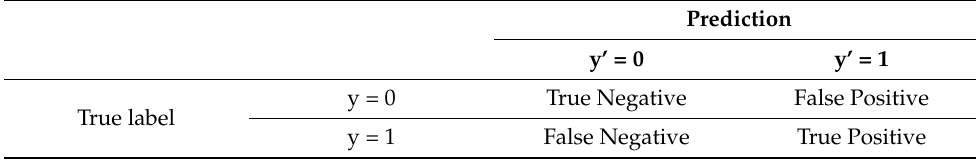
Table 2. Classification performance evaluation of the proposed model. Table 1. Confusion Matrix.